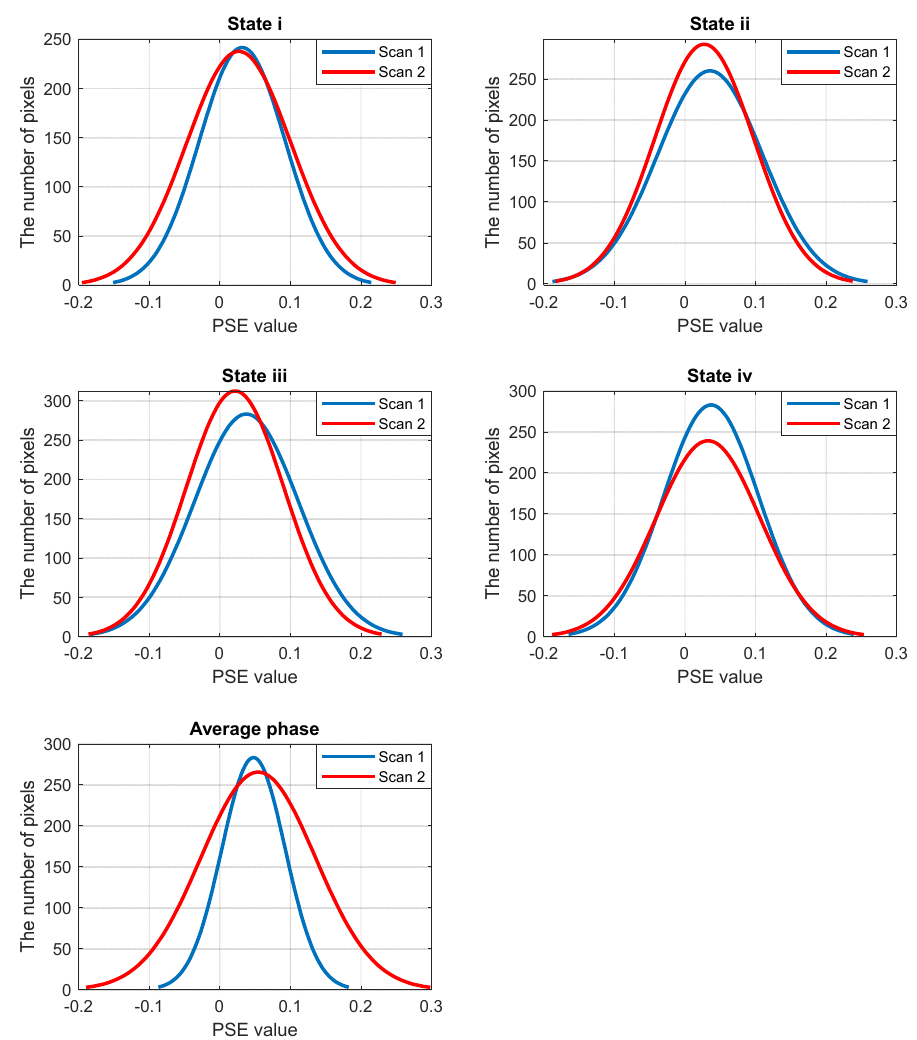
Figure 10. PSE distribution of both average phase and four segmented states on two scans that performed within two weeks.